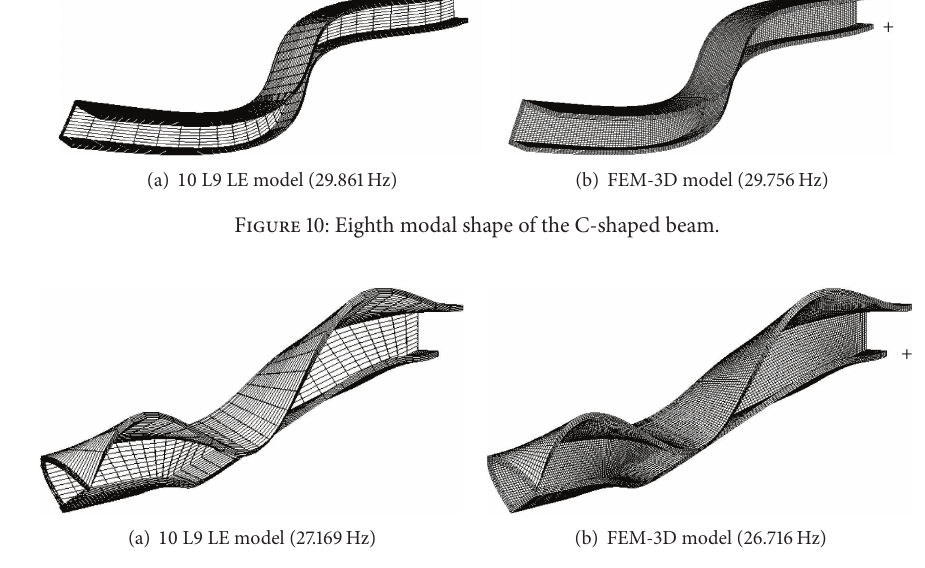
Figure 11: Eighth modal shape of the C-shaped beam with a non-structural mass at the tip cross-section (Figure 9).